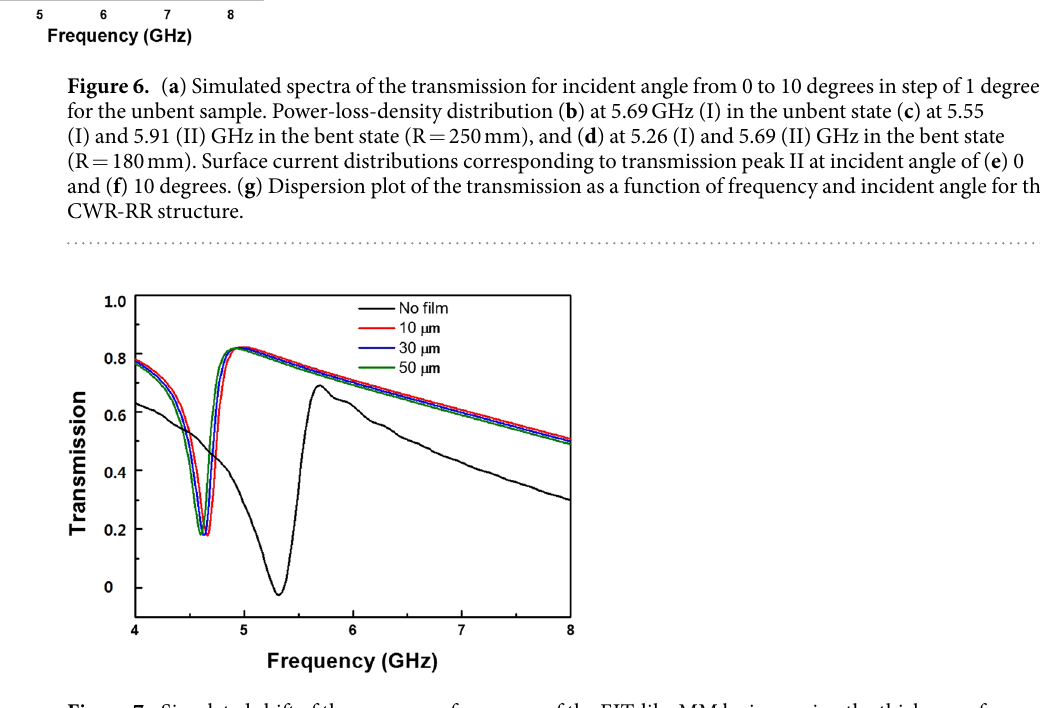
Figure 7. Simulated shift of the resonance frequency of the EIT-like MM by increasing the thickness of